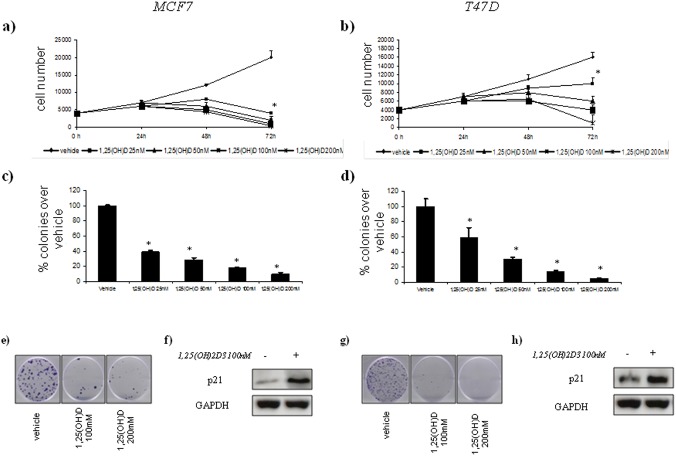
Vitamin D anticancer effects in vitro on ER(+) breast cell lines with different Cdx2 status.Time-dependent growth curves of MCF7 (a) and T47D (b) cells in the absence or in the presence of different doses of 1,25(OH)2D3 (25–200 nM). Histograms (c and d) showing average colony percentage over vehicle from duplicate experiments at 10–21 days from seeding. Bars indicate the average of three independent experiments. * statistics: p < 0.05. Representative micrographs of colonies formed by BT-20 (e) and HCC1954 (g) cells treated with 1,25(OH)2D3 as indicated. Representative western blot analysis of whole cell lysates obtained from MCF7 (e) and T47D (f) cells treated as suggested and stained with the indicated antibodies. GAPDH staining was used as a loading control.